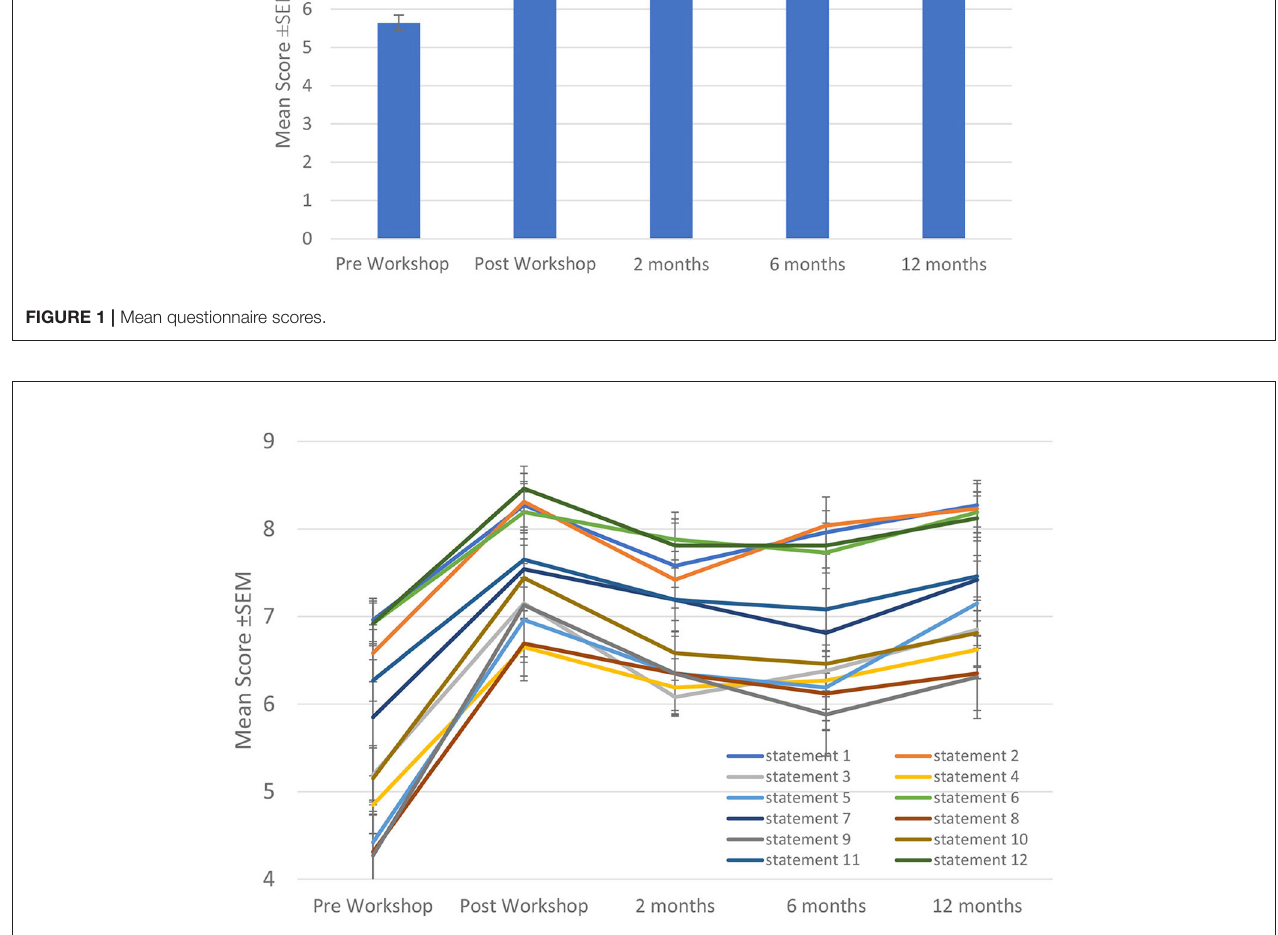
FIGURE 2 | Self-esteem questionnaire individual statement